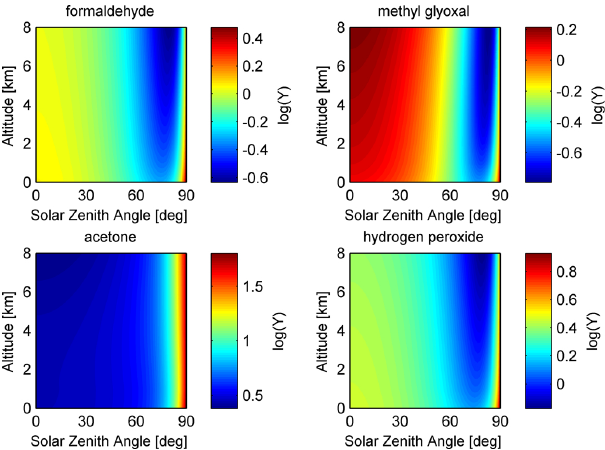
Fig. 9. The ratio of the rate of gas phase OH oxidation to the rate of gaseous photolysis, Y , as a function of solar zenith angle and alti- tude for compounds where the absorption cross sections and quan- tum yields are published as a function of temperature and pressure. Upper and lower limits of these plots, due to the uncertainty in the empirical function relating OH concentration to the rate of photoly- sis of O 3 to O( 1 D), are presented in the